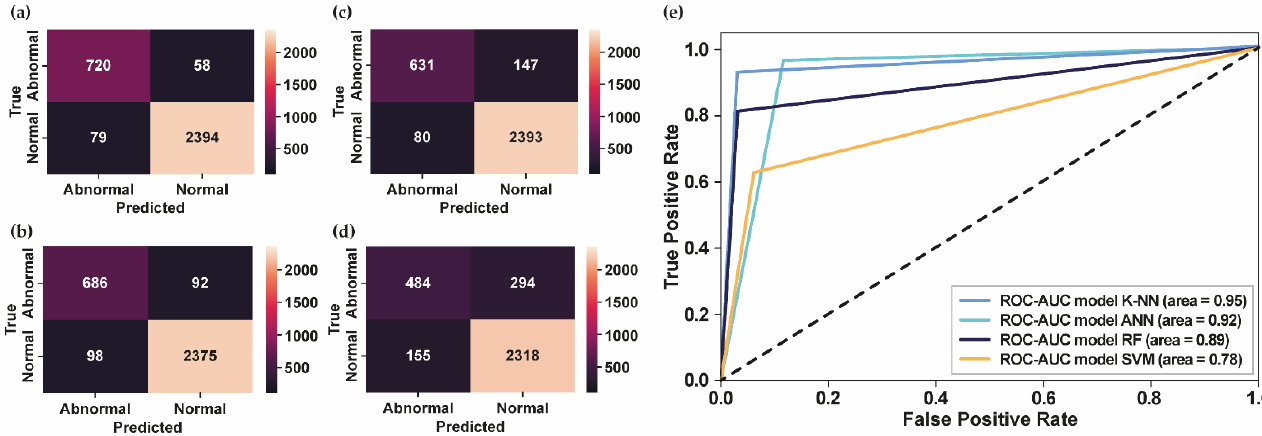
Figure 4. The confusion matrix and ROC curve for PhysioNet Challenge 2016. ( a ) The confusion matrix of test datasets using K-NN; ( b ) The confusion matrix of test datasets using ANN; ( c ) The confusion matrix of test datasets using RF; ( d ) The confusion matrix of test datasets using SVM; ( e ) The ROC curve of several classifier models.